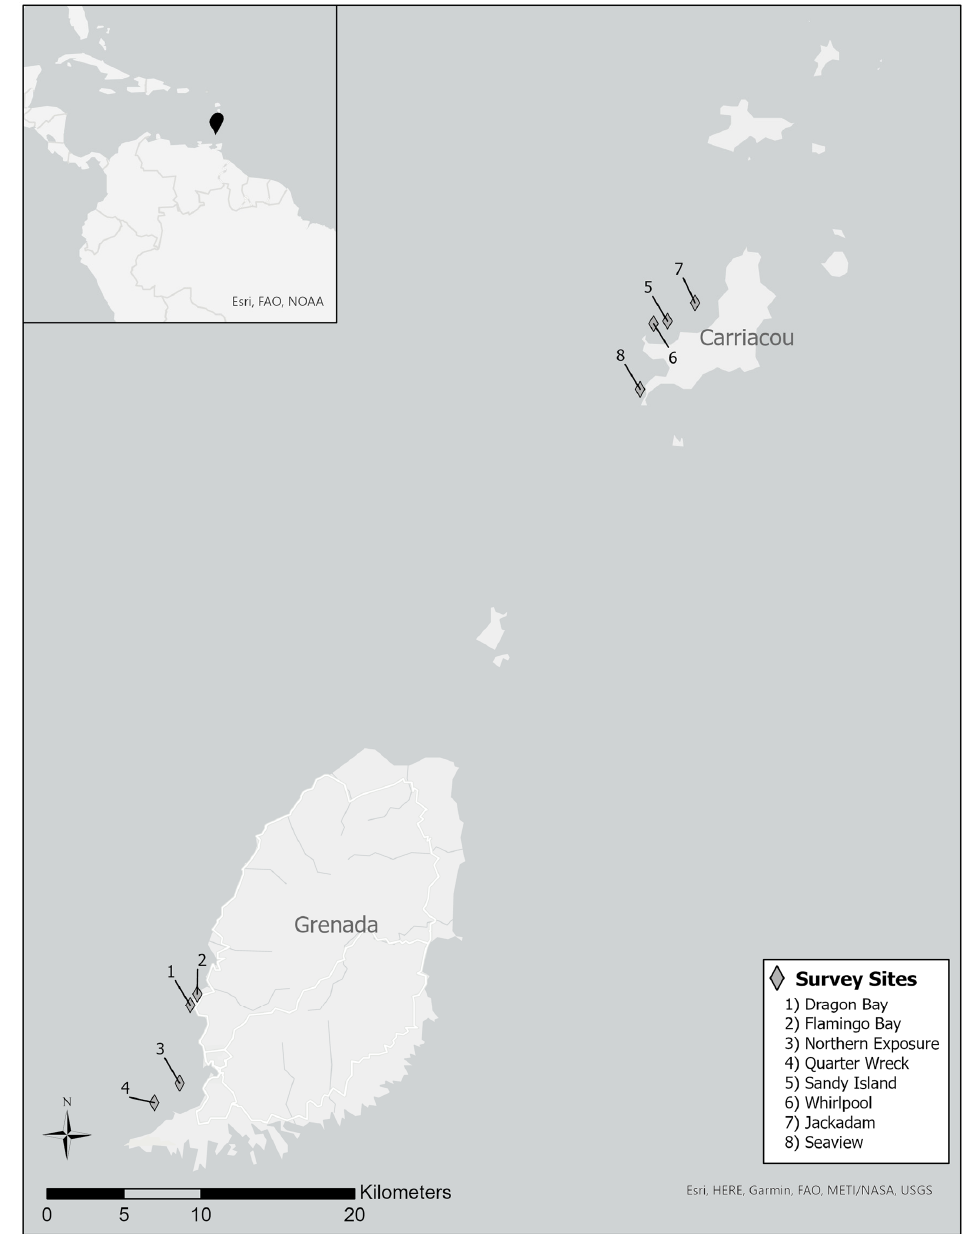
Figure 1. Location of survey sites in Grenada and Carriacou, Eastern Caribbean (inset). The sites on Carriacou were chosen to mirror those in Grenada in that they were approximately equivalent distances from shore, found at similar depths, had benthic community assemblages that appeared similar during initial visual assessments, and were all frequented by the recreational dive industry. All surveyed sites were comprised of shallow patch reefs on the leeward side of each island. Each site was marked with 1 m rebar stakes that were driven into coral rubble at the ends of 30 m long transects running across patch reefs in the nearshore waters of Carriacou. Each site in Grenada and Carriacou had four transects running parallel to each other spaced 5 m apart. All transects ranged in depth from 9.4 m to 12.2 m. Sites on Carriacou were established in the last week of August 2014 with the authorization of the Grenada Ministry of Forestry, Fisheries and